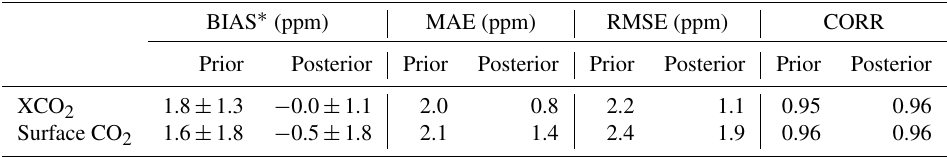
Table 1. Statistics of the simulated surface CO 2 and XCO 2 concentrations against the surface flask observations and GOSAT retrievals, respectively.